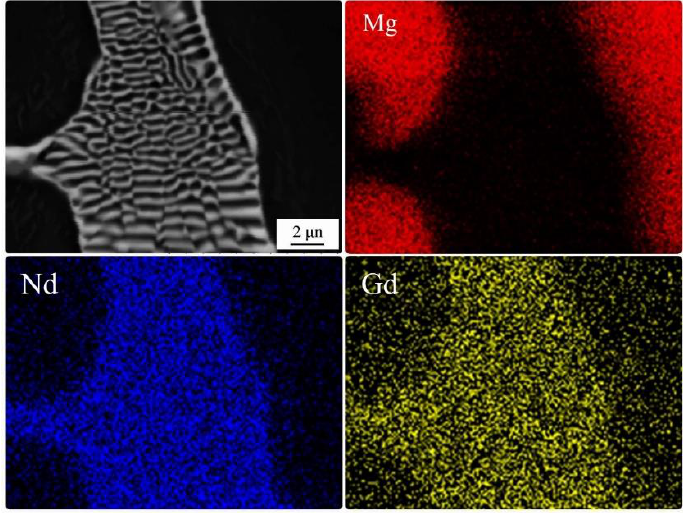
Figure 2. EDS-map analysis of as-cast modified EV31.